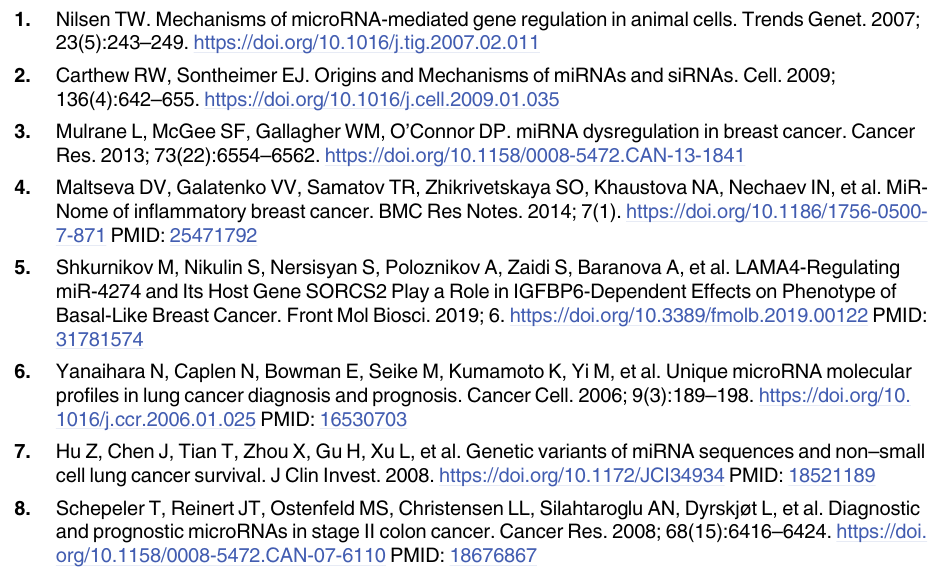
S6 Table. Differential expression analysis of E2F1 and its target genes. S7 Table. Number of patients in analyzed cohorts. S8 Table. Values of n and k